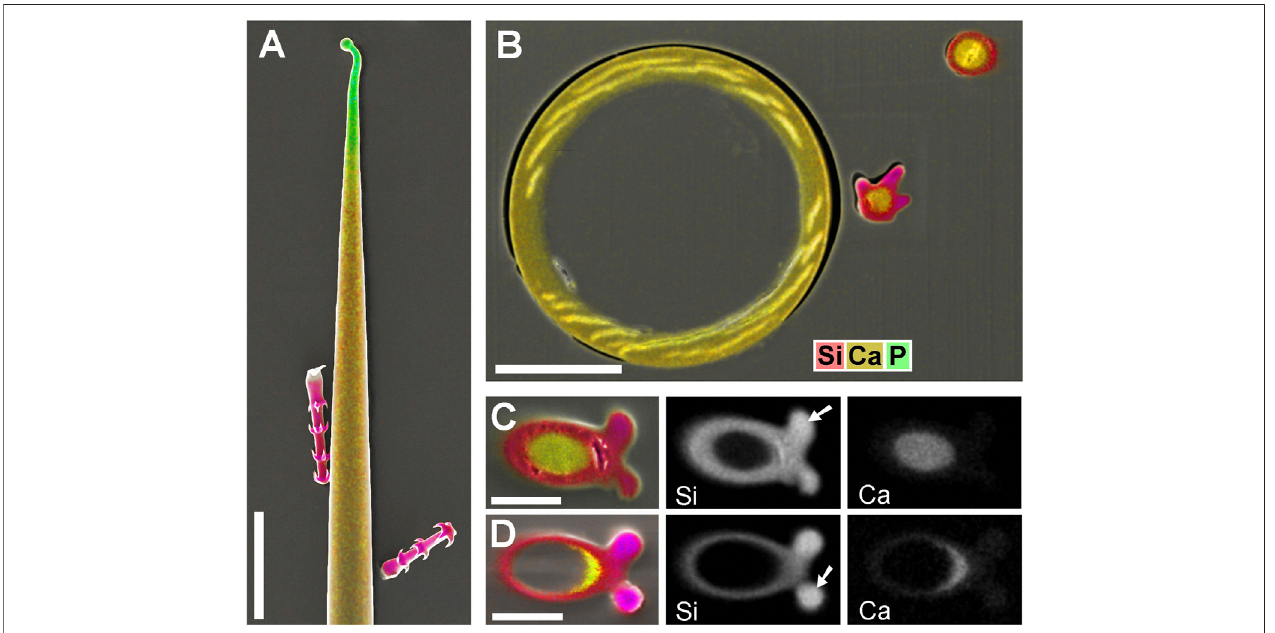
FIGURE4 | Blumenbachia insignis , combined topographic and element-mapping imagesofstinginghair and glochidiate trichomes. Colors: Sishown in red,Ca in yellow, and P in green. (A) Surface view of part of a stinging hair (yellow, green) and two glochidiate trichomes (red, indicating Si). (B) Section through a similar arrangementoftrichomesshowsthatstinginghairwallismineralizedwithCacompoundsacrossentirethickness.Glochidiatetrichomeshaveasilici fi edregularwall,very high Si concentration in barbs (arrows), and Ca in deposits in cell lumen. (C – D) Cross sections through massive and hollow regions of glochidiate trichomes including barbs; combined colour images and separate element maps of the Si and Ca distribution. Scale bars: A (cid:1) 100 μ m; B (cid:1) 30 μ m; C-D (cid:1) 10